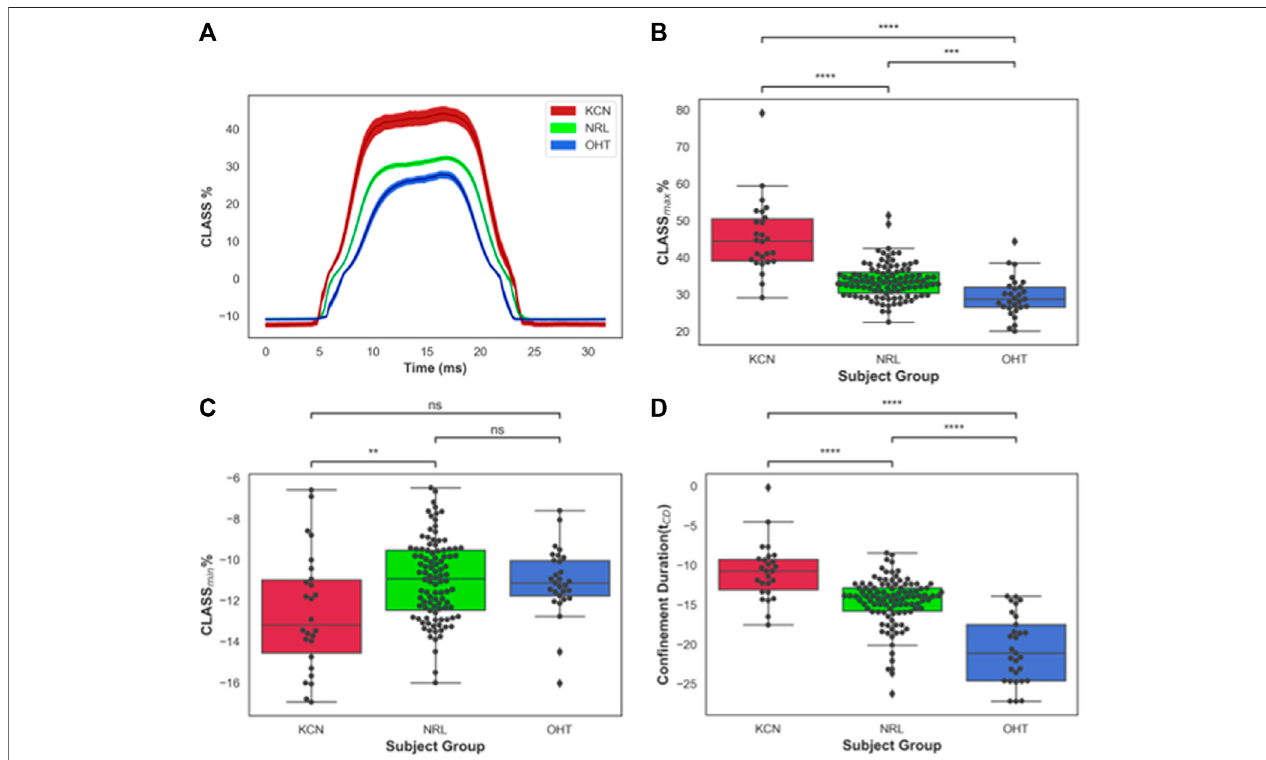
FIGURE 2 | (A) CLASS% time-series plot shown in mean ± standard error (shaded area) for keratoconus (KCN), normal (NRL), and ocular hypertension (OHT) subjects; (B) Distributionofmaximum CLASS forKCN,NRL,andOHTsubjects; (C) Distributionofminimum CLASS forKCN,NRL,andOHTsubjects; (D) Distributionof concavephase duration ( t CD ) for KCN, NRL, and OHT subjects. P -value annotation legend: ns: 0.05 < p , *: 0.01 < p ≤ 0.05; **: 0.001 < p ≤ 0.01; ***: 0.0001 < p ≤ 0.001; ****: p ≤